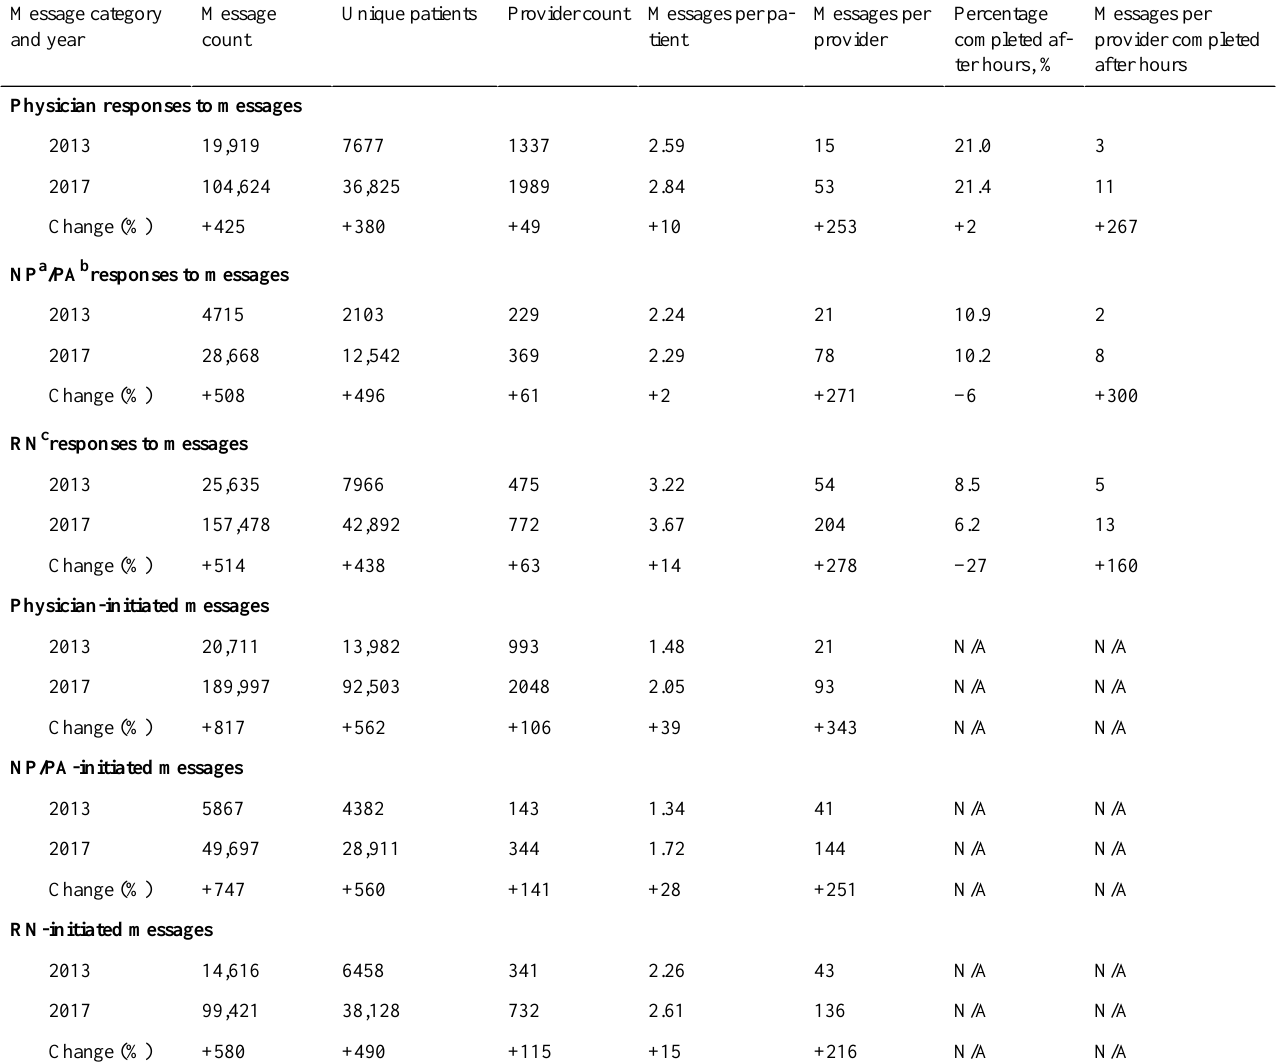
Table 4. Specialty care messages.